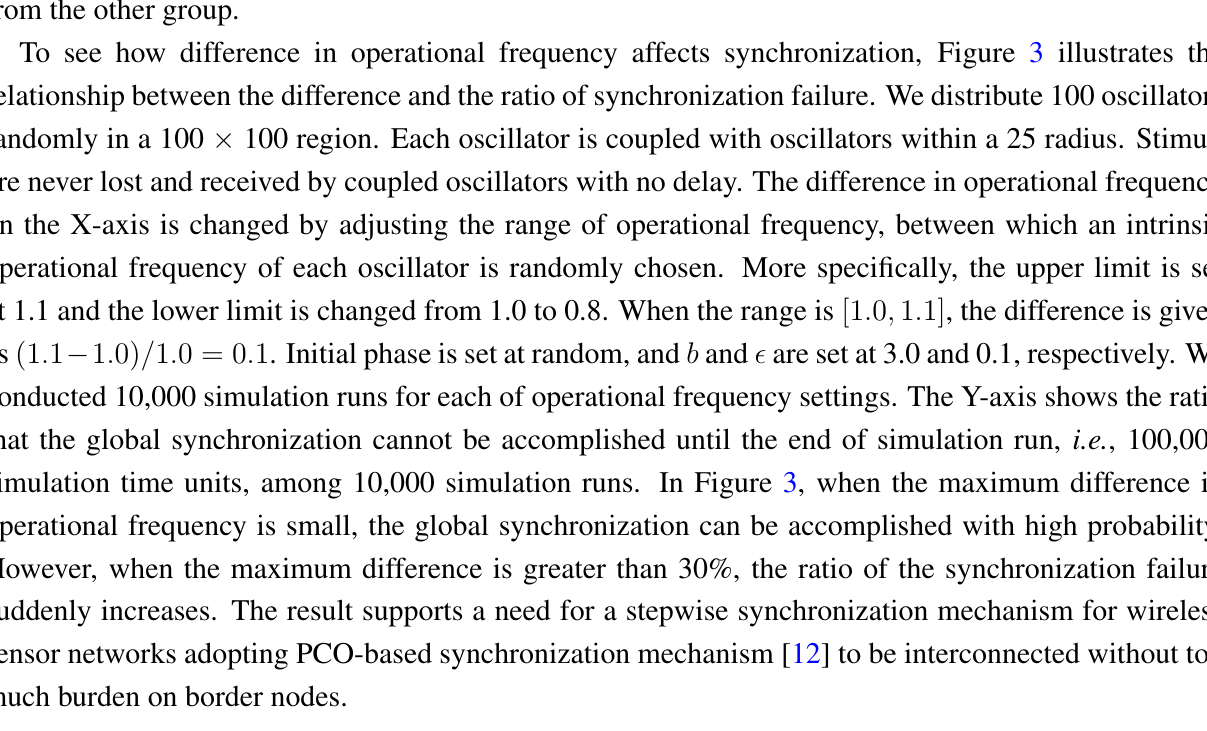
Figure 3. Ratio of synchronization failure against maximum difference in operational